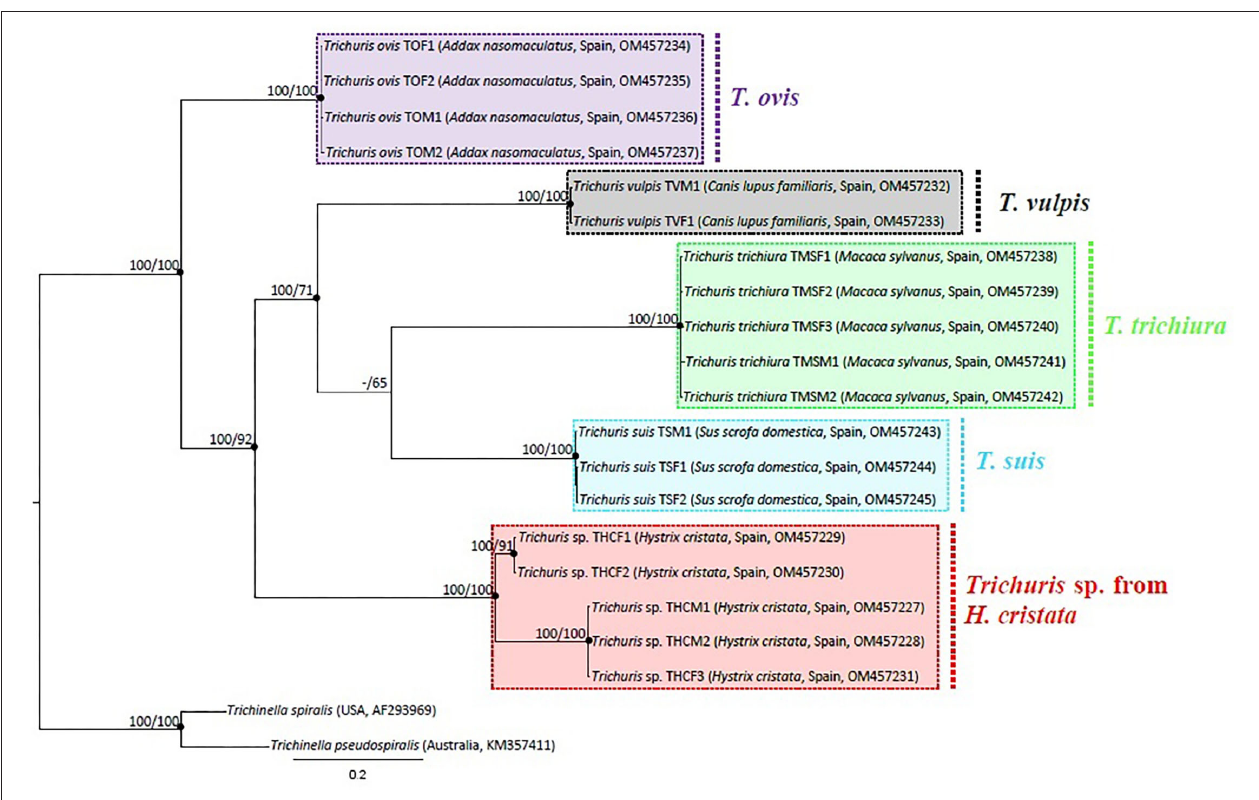
FIGURE 5 | Phylogenetic tree based on analysis of mtDNA cyt b partial gene using Bayesian Inference. Maximum likelihood bootstrap values are listed first, followed by Bayesian Posterior Probabilities of clades, for clade frequencies exceeding